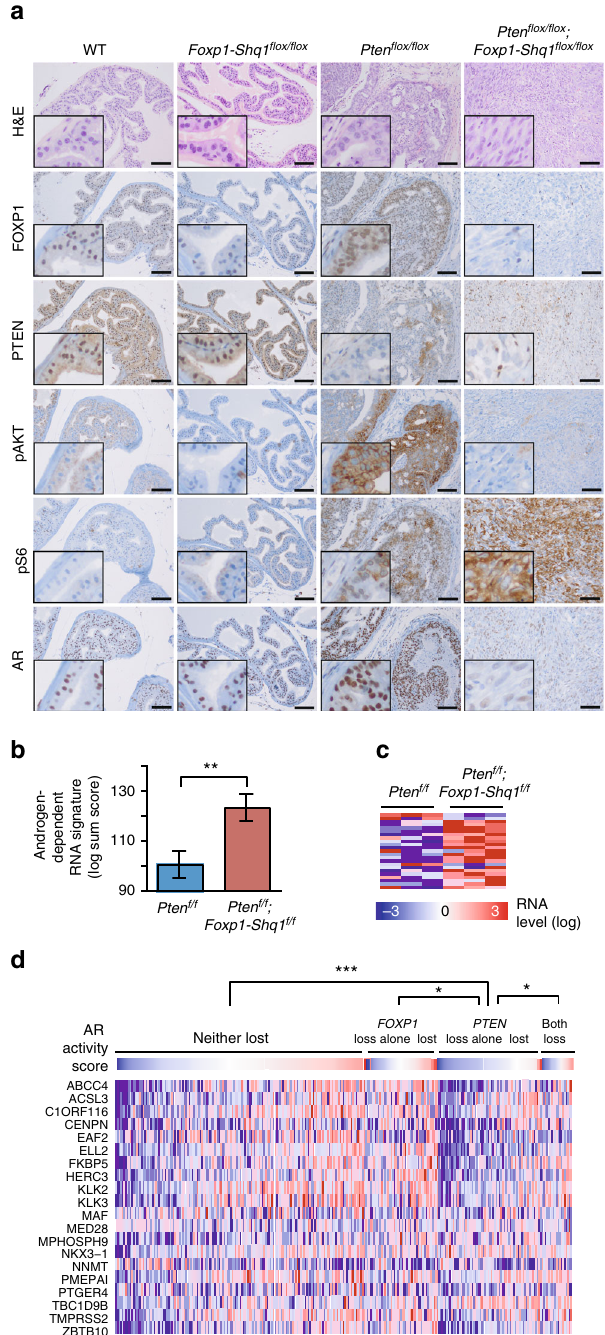
Fig. 3 PI3K and AR pathways are altered upon cooperative loss of Pten and the Foxp1-Shq1 locus, resulting in restoration of androgen-responsive gene expression. a Comparison of prostate histology (H&E) and FOXP1, PTEN,